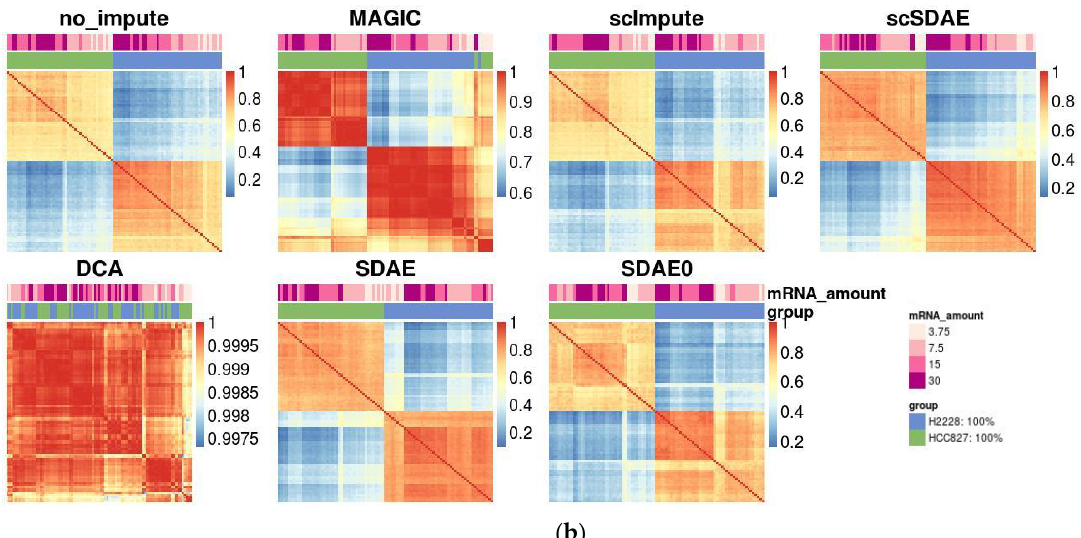
Figure 3. Comparisons of imputation methods using RNA mixture dataset. ( a ) Average Pearson correlation coefficients for cells within the same groups in the CEL-seq2 and Sort-seq datasets (n = 2) from different combinations of normalization and imputation methods. ( b ) Heatmaps of Pearson correlation coefficients for samples in the CEL-seq2 dataset that contained pure H2228 (n = 45) or HCC827 (n = 44) RNA obtained from different imputation methods after TMM normalization.